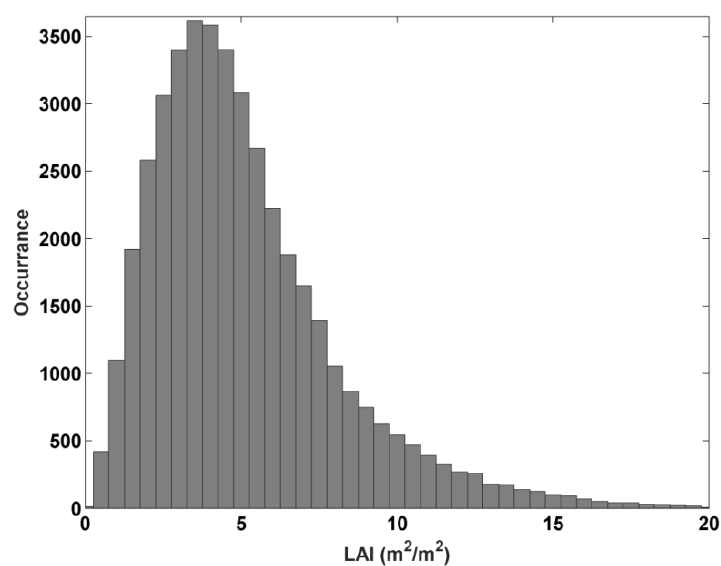
Figure 10. Histogram of the LAI derived from the airborne LiDAR for the tropical mountain rain forests of Bélouve (BF).